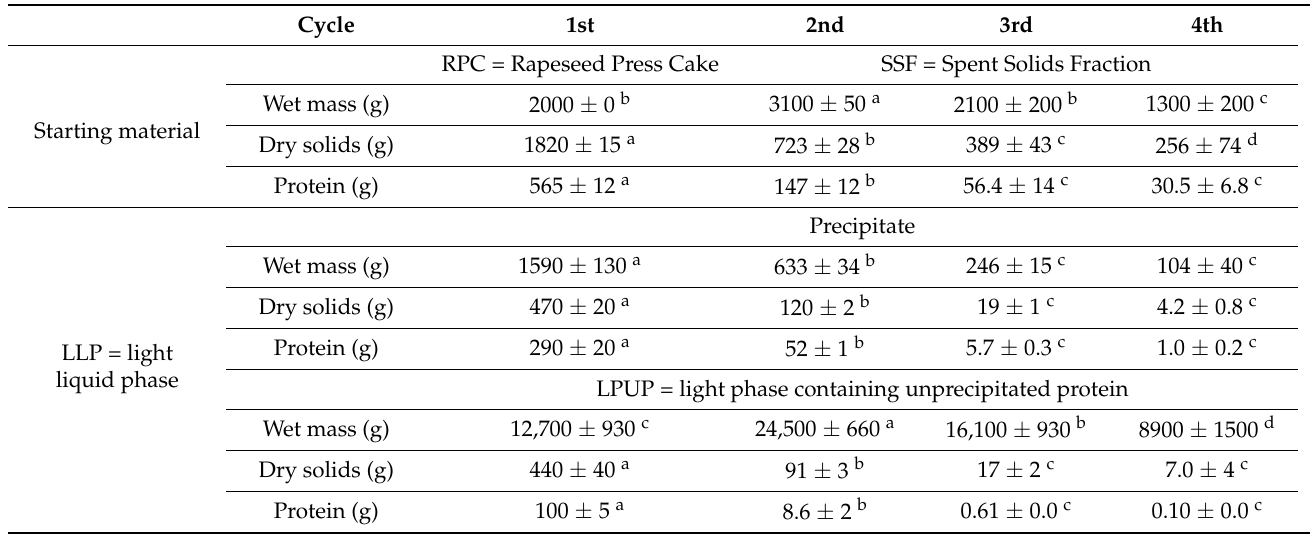
Table 1. Wet mass, dry solids, and protein in the starting material, precipitate, and LPUP for all four cycles. All data are expressed as the mean ± standard deviation. Different letters in each row indicate significant differences, p ≤